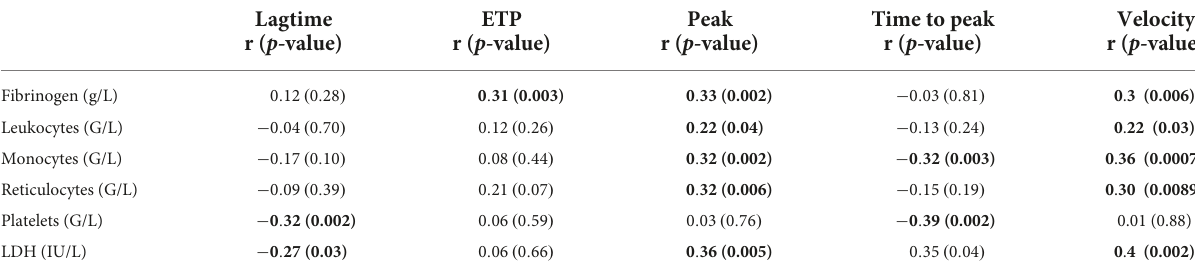
TABLE 2 Correlation of TGA parameters in all SCD genotypes at steady state.